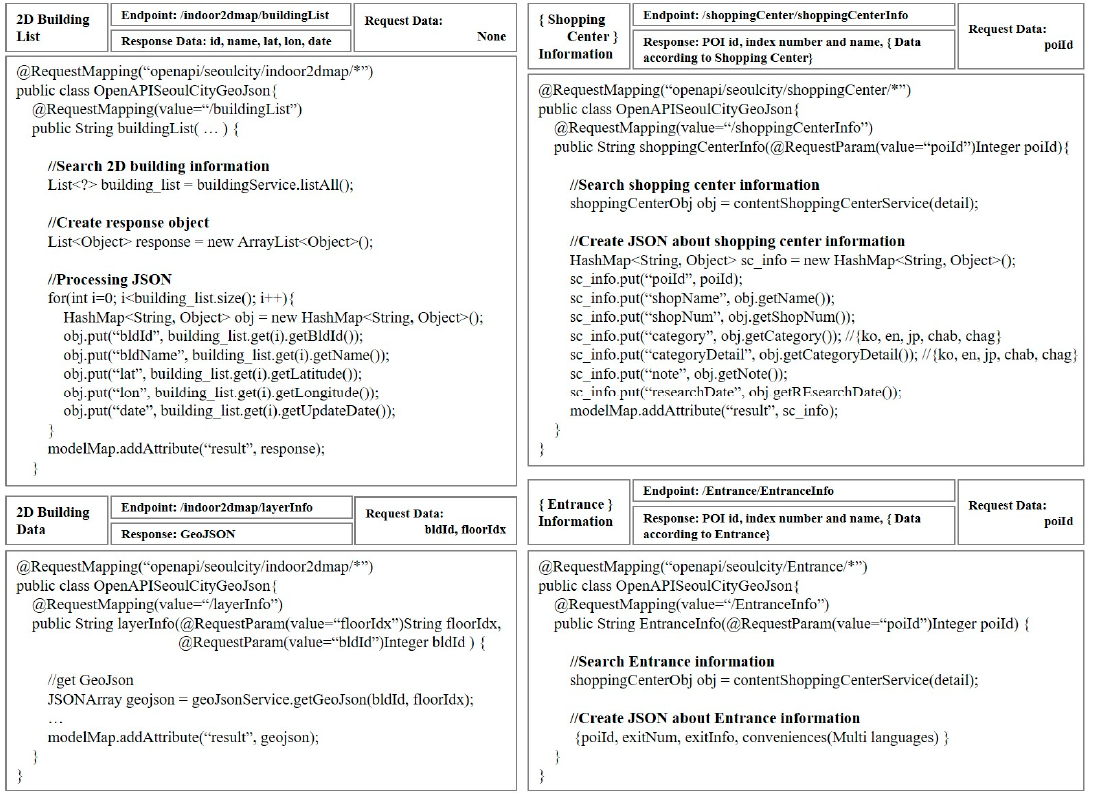
Figure 7. Implementation examples of an Open API related to 2D building information.